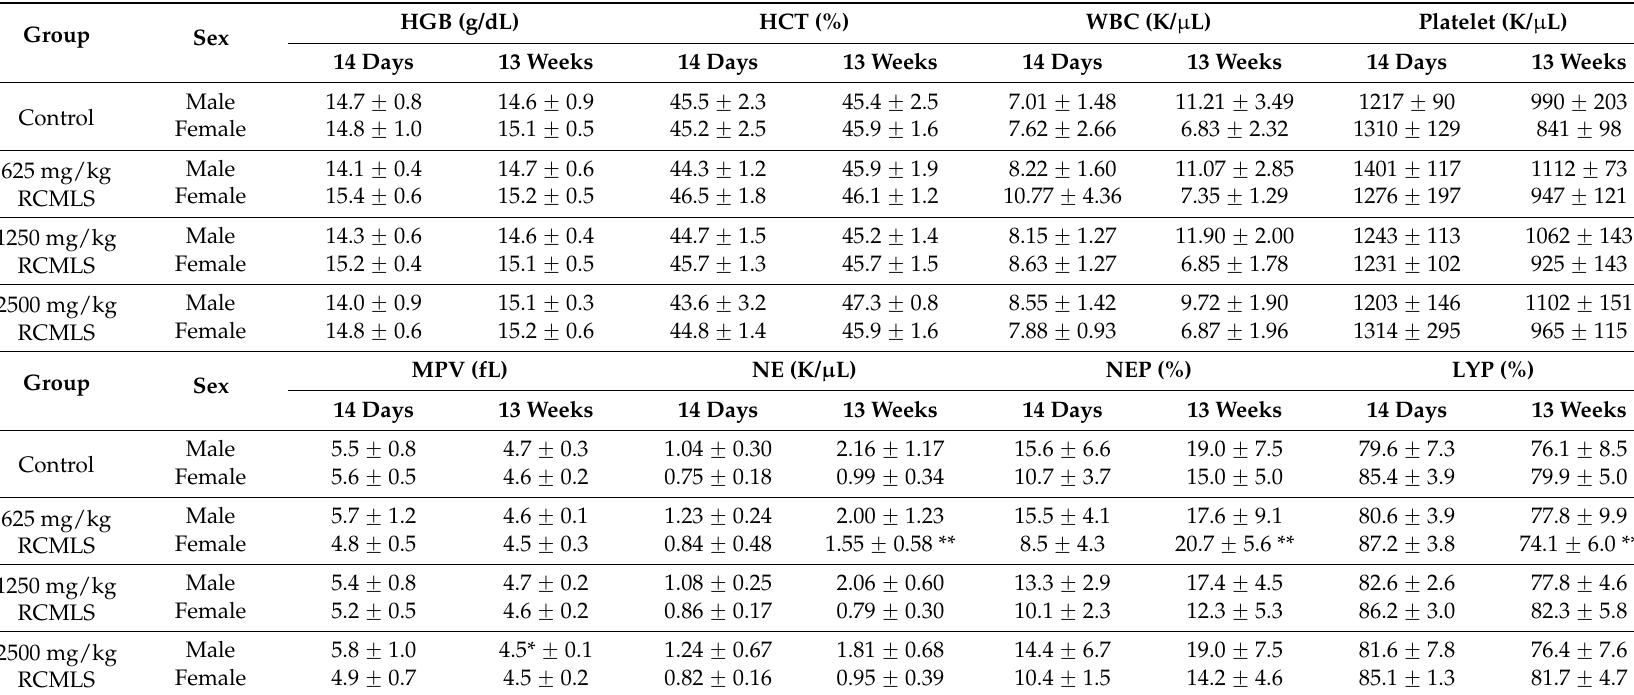
Table 6. Hematological values of male and female rats in 14 days repeated oral dose and 13 weeks repeated oral dose toxicity studies of the leaves and stems of Rubus coreanus Miquel